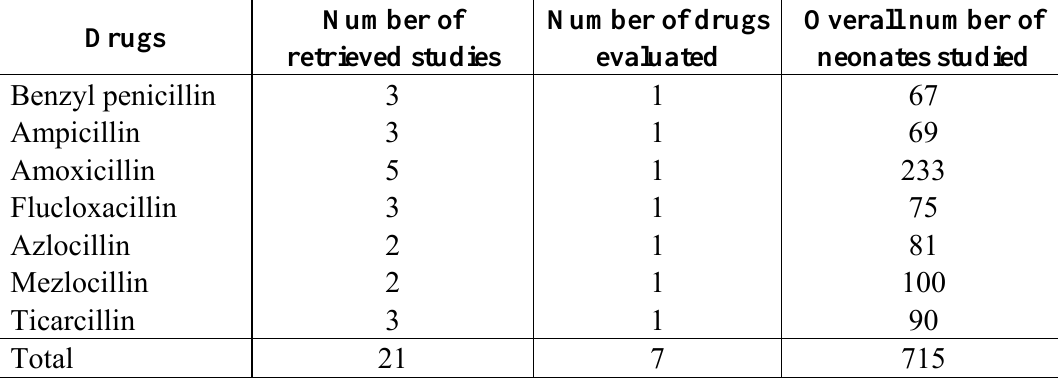
Table 1. Number of retrieved studies and number of drugs